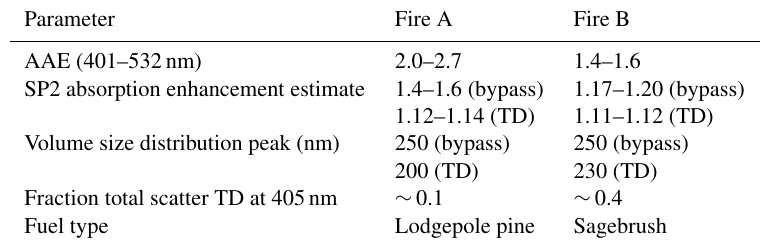
Figure 4. Total integrated scattering for (a) Fire A and (b) Fire B at 405nm measured by the imaging nephelometer (blue circles), inte- grating nephelometer (grey line; measured at 450nm and adjusted to 405nm), and CRD PAS (black line; extinction 405nm – absorption 401nm). Yellow shaded regions indicate when the instruments were sampling behind the thermodenuder. Integrating nephelometer data were unavailable after 13:58 in Fire B (see text). Table 1. Selected measured values demonstrating the key differences between the aerosol products from Fire A and Fire B. Note: TD stands for